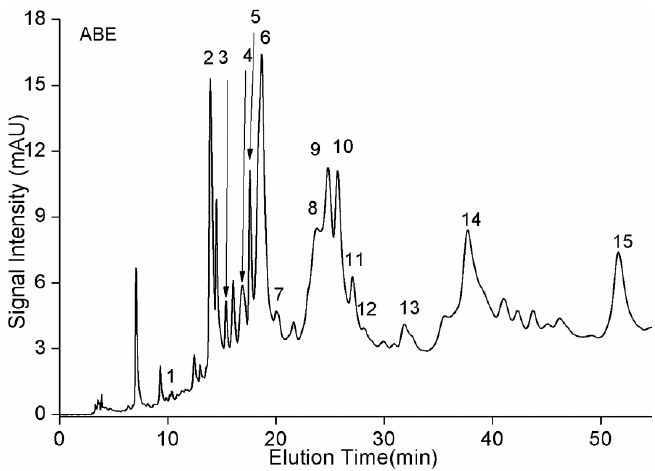
Figure 2. Representative reverse-phase HPLC/VWD chromatograms of PAs from ABE. Table 1. Components identified in the ABE by LC/MS.